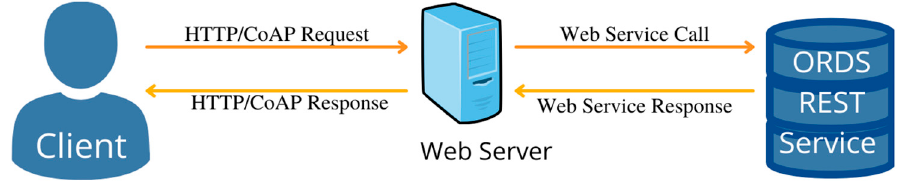
Figure 12. REST API. The client requests for a service and the web server calls for it.